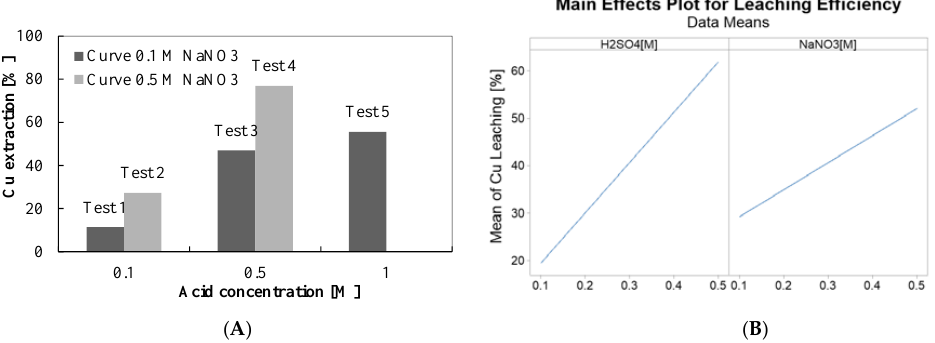
Figure 3. ( A ) E ff ect of the acid concentration on the extend of the copper concentrate at room temperature and ( B ) E ff ect of concentrations of H 2 SO 4 and NaNO 3 on the leaching e ffi ciency of copper